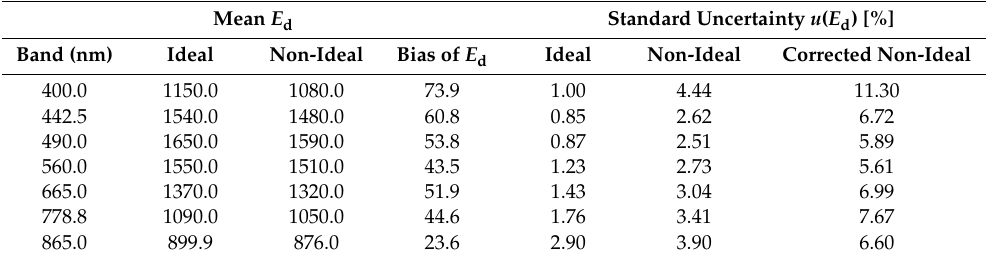
Table 2. The mean and standard uncertainty as a percentage of the mean of the downwelling irradiance, E d [mWm − 2 nm − 1 ], presented for the ideal and non-ideal cases. Reproduced with permission from